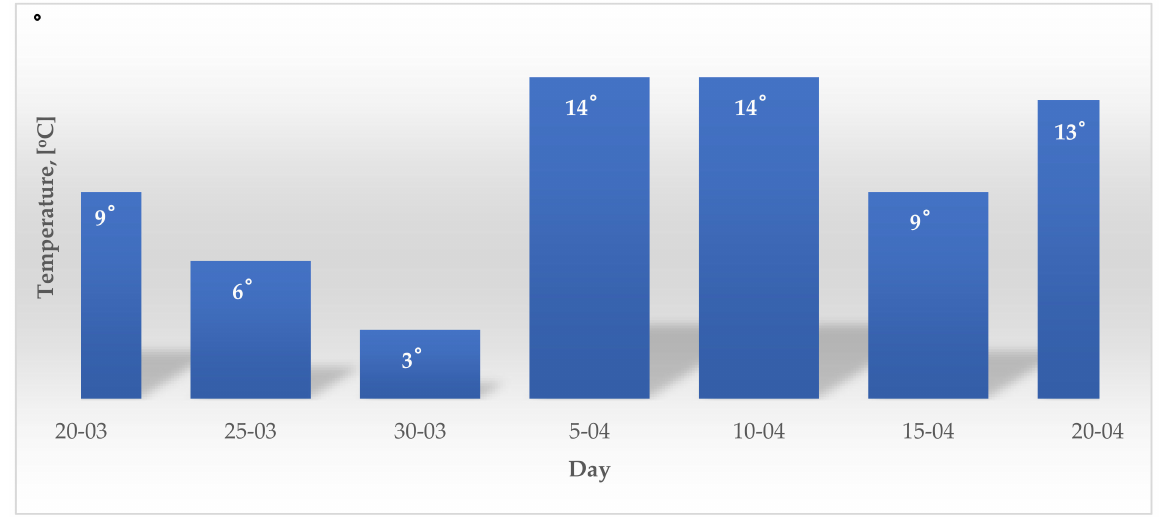
Figure 6. Air temperature in the studied period (on 20 March = to 20 April). Based on data from Institute of Meteorology and Water Management National Research Institute